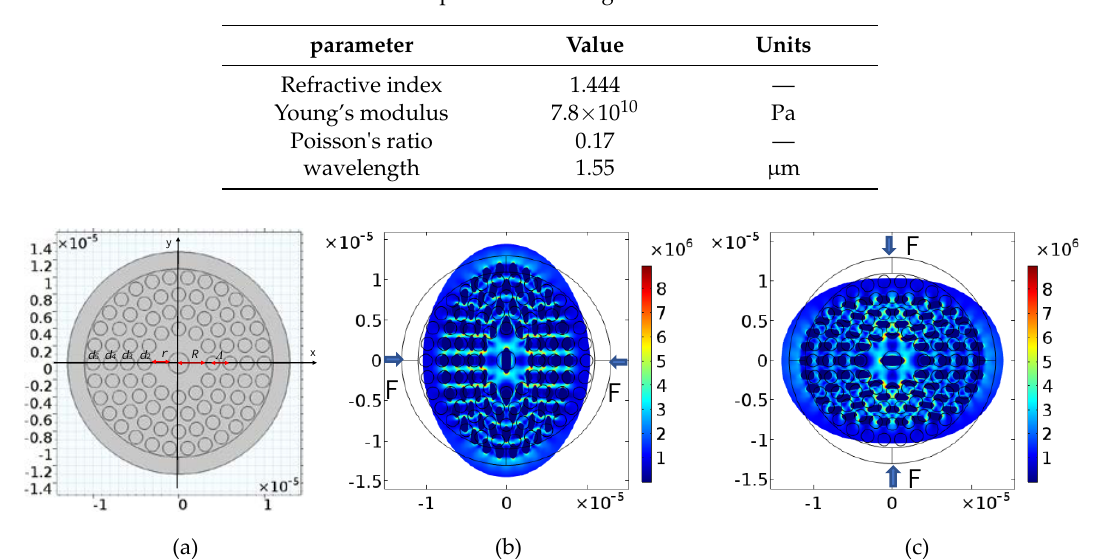
Figure 2. (a) Hollow-core C-PCF cross section without stress; (b) hollow-core C-PCF deformed under Figure 2. ( a ) Hollow-core C-PCF cross section without stress; ( b ) hollow-core C-PCF deformed under x x direction external force; (c) hollow-core C-PCF deformed under y direction external force direction external force; ( c ) hollow-core C-PCF deformed under y direction external